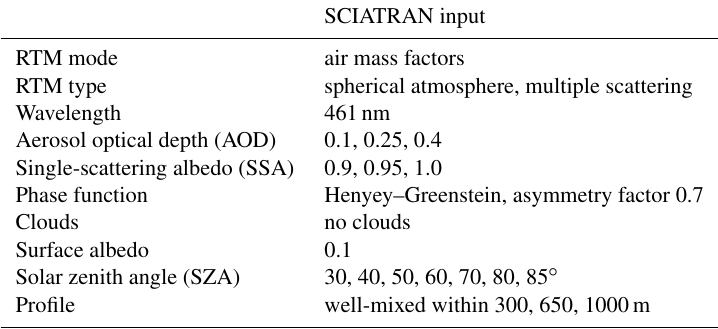
Table 4. Parameter settings used for the simulation of tropospheric air mass factors with the radiative transfer model